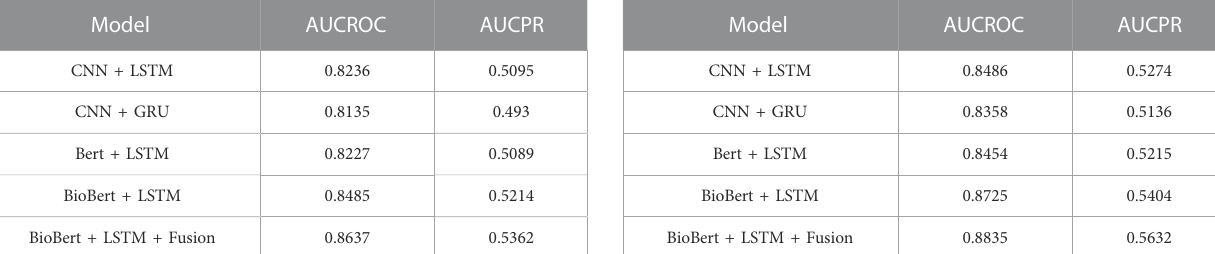
TABLE 3 Performance of each model in the 4 clinical record.